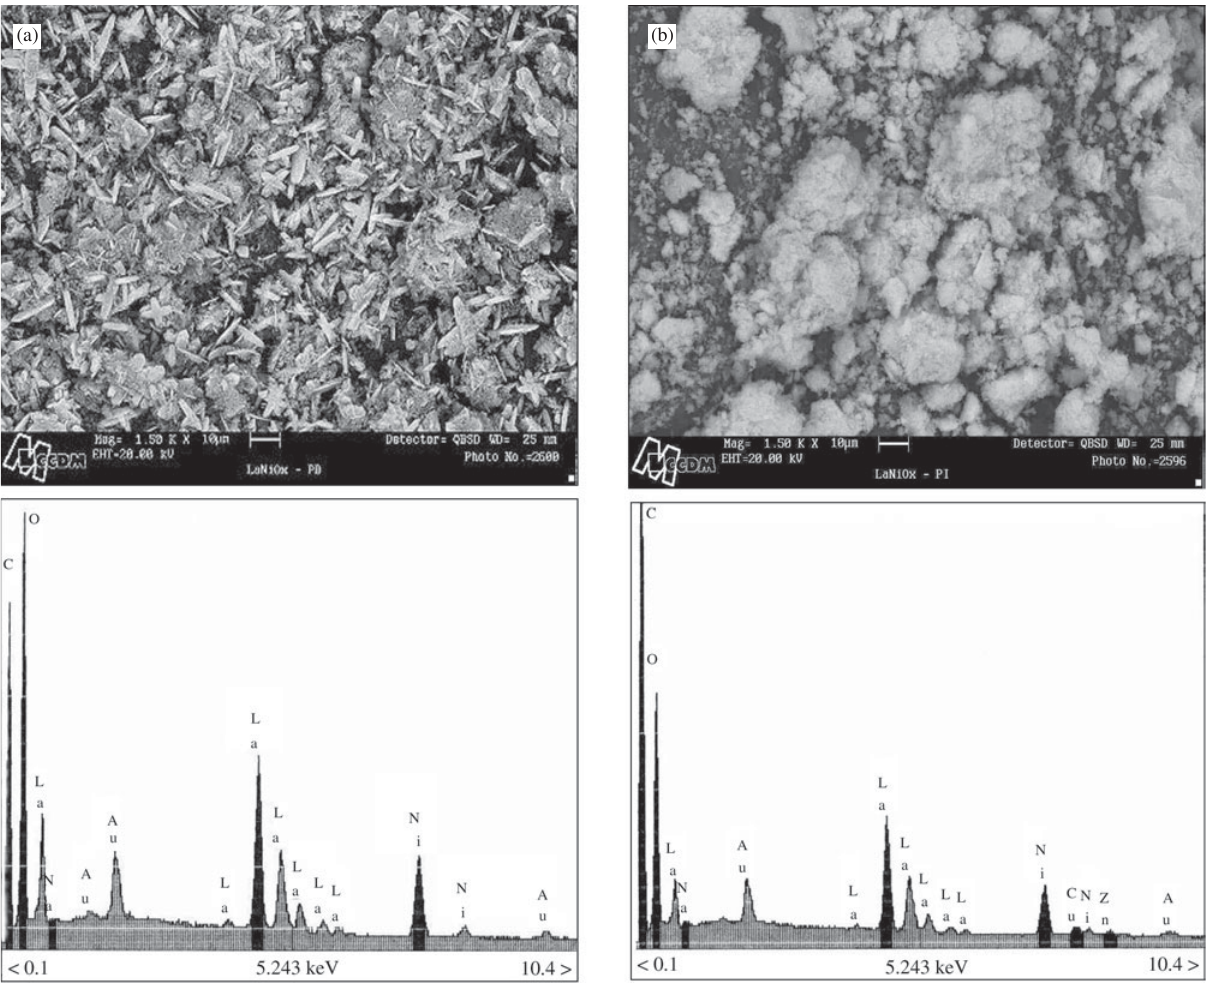
Figure 2. Scanning electron microscopy coupled to energy dispersive X-ray spectrometry for LaNiO